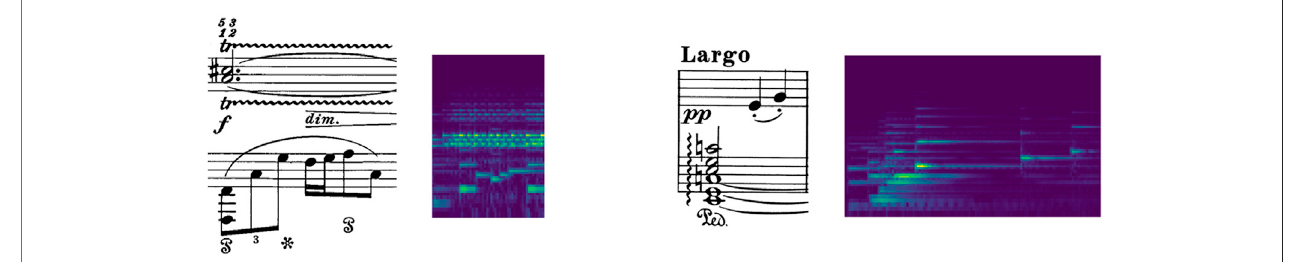
FIGURE 8 | Example of a trill (left) and an arpeggio (right) , as they look in the score and an audio recording,